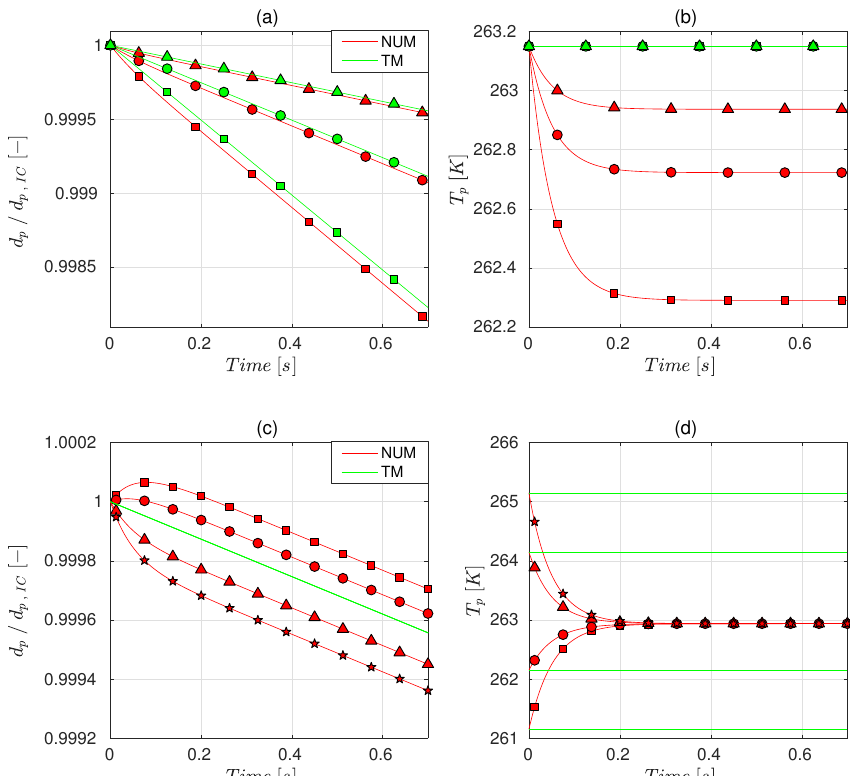
Figure 2. TM and NUM solutions for a particle of 200µm diameter in different environmental conditions. Experiment I-A: evolution of particle (a) diameter and (b) temperature; T p , IC – T Air = 0, σ ∗ = 0 . 8 (squares), 0.9 (circles), 0.95 (triangles). Experiment I-B: (c) – (d) same as (a) – (b) with σ ∗ = 0 . 95; T p , IC – T Air = − 2K (squares), − 1K (circles), 1K (triangles), 2K (stars). Note that the particle diameters